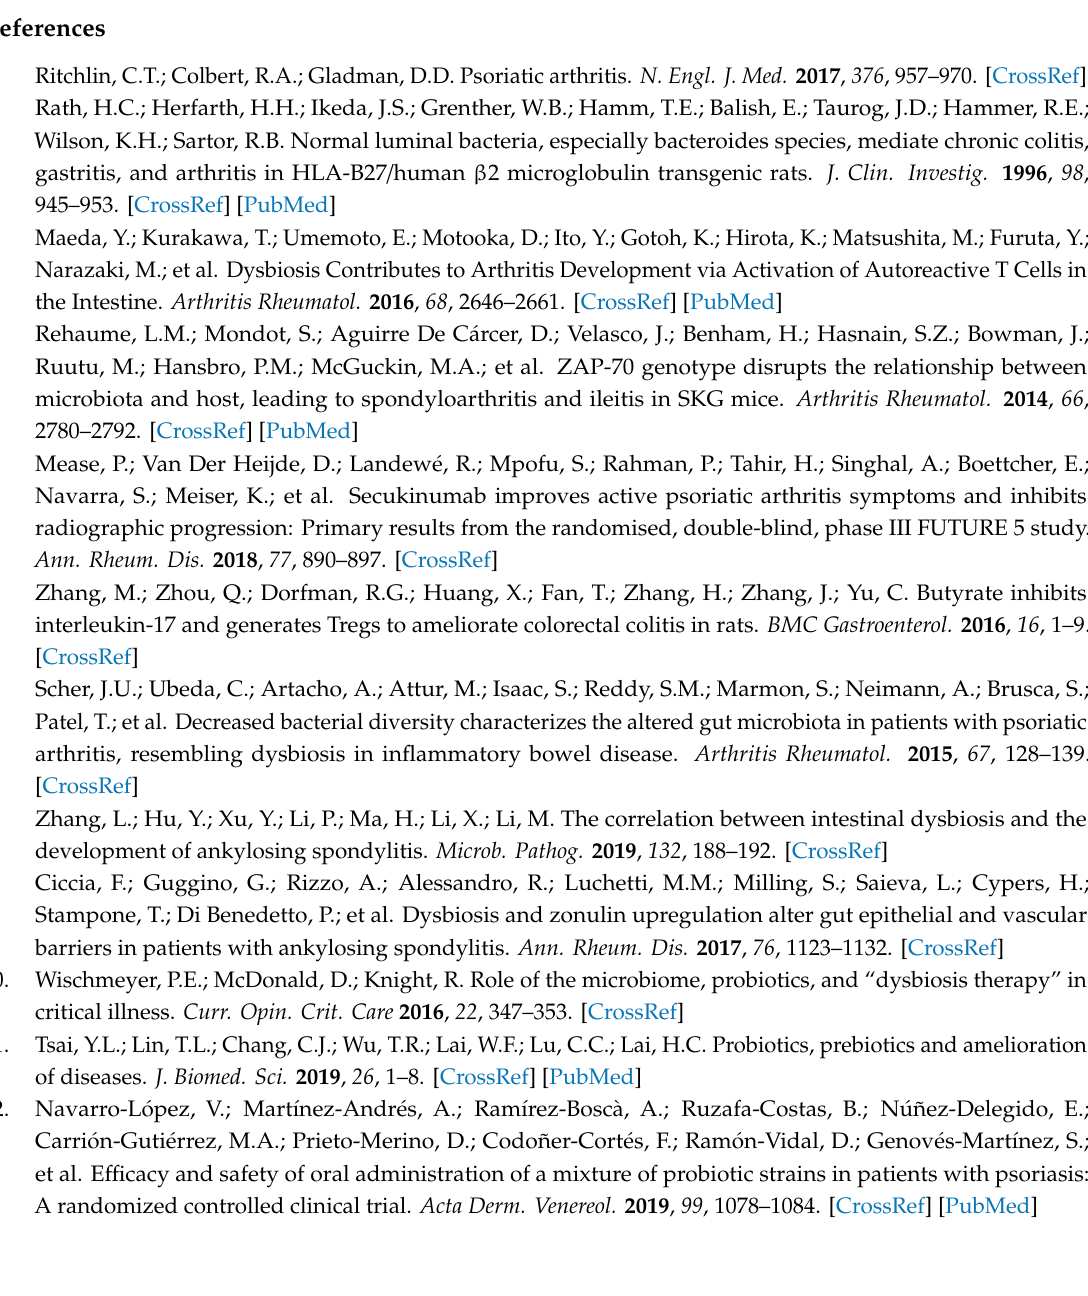
Table S1: Bacterial composition of OMNi-BiOTiC ® STRESS Repair, Table S2: Data of mPASDAS score elements at baseline as well as week 12 and